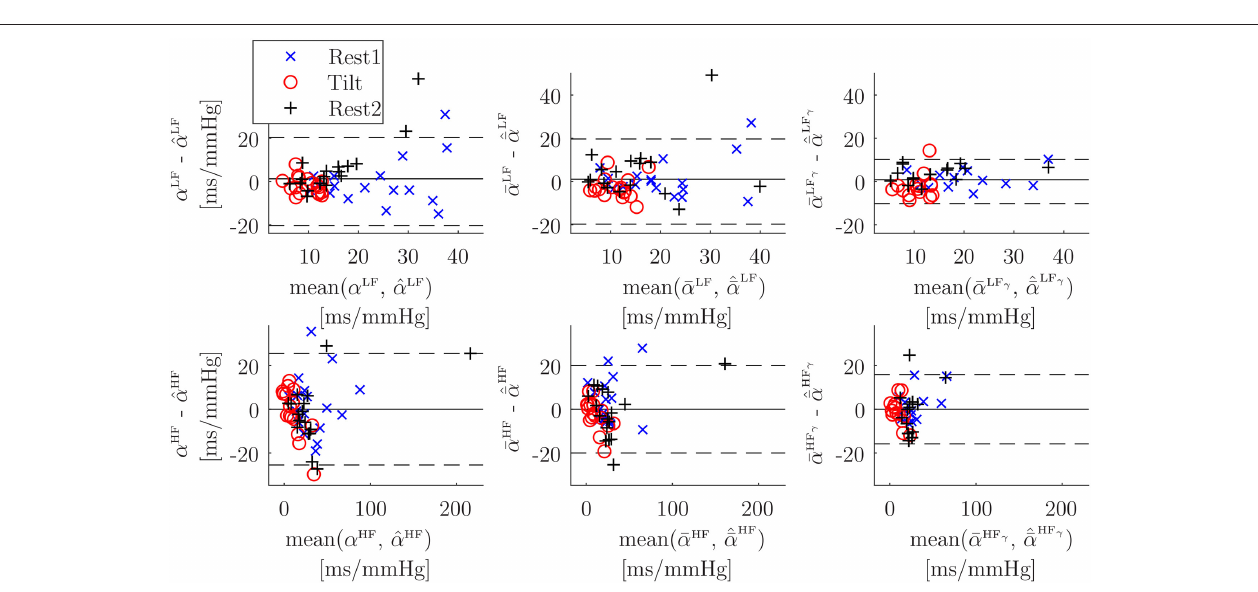
FIGURE 6 | Bland-Altman plots of α vs. α PUS indices (Welch-periodogram approach, first column), of ¯ α vs. ¯ α PUS indices (time-frequency approach, second column), and of ¯ α γ vs. ¯ α γ PUS indices (time-frequency coherence approach, third column), after a linear regression to convert all units to ms/mmHg. Note that scales are not the same for LF band (first row) than for HF band (second row).